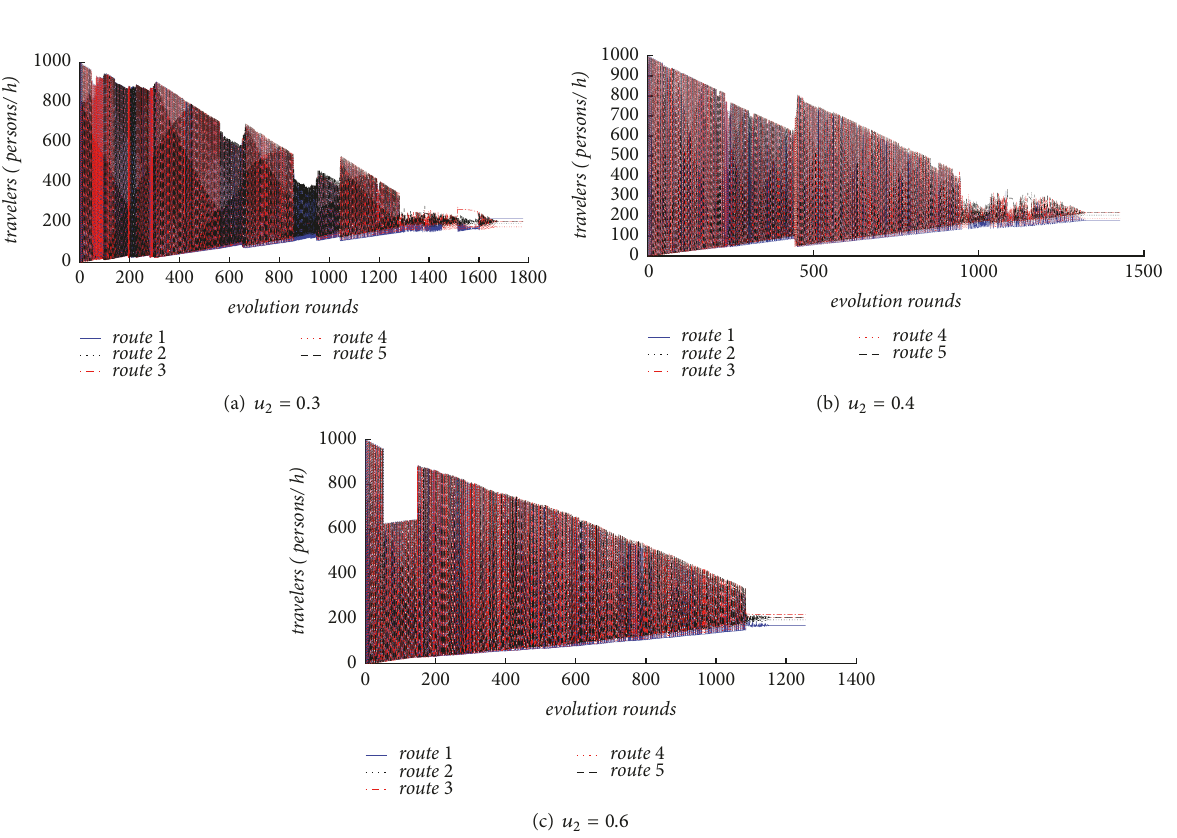
Figure 9: Volume evolution of five routes for 𝑞 = 1000 , 𝛼 = 0.3 , Δ = 0.2